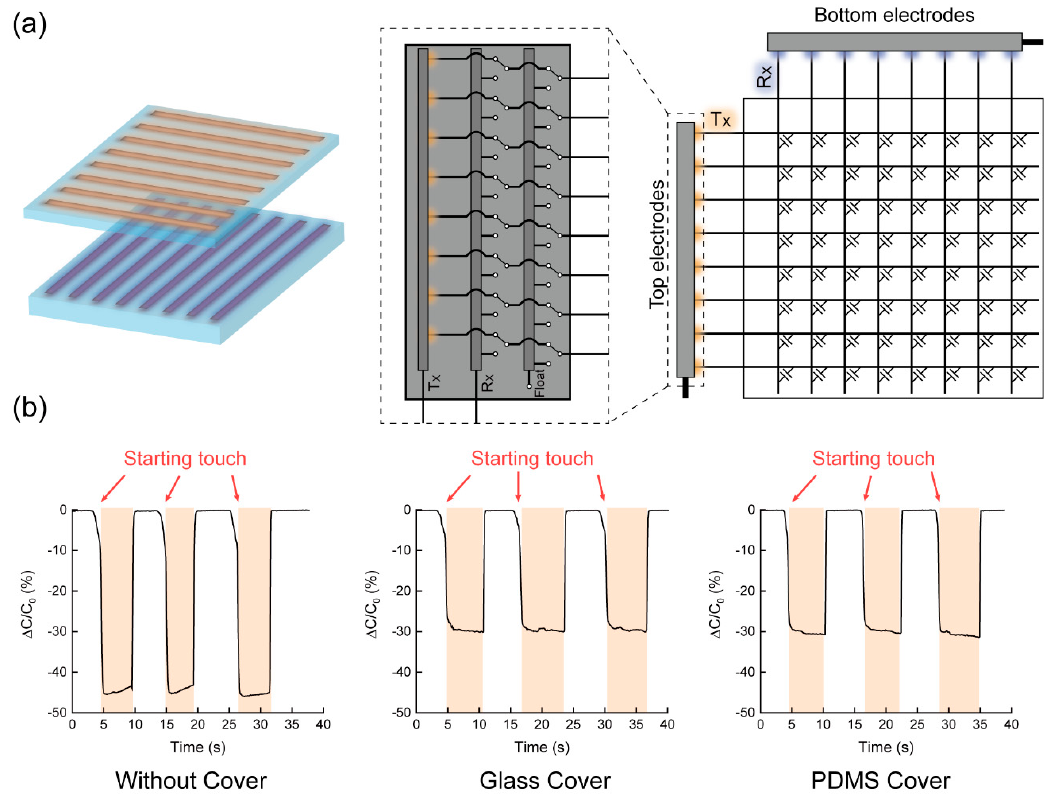
Figure 2. ( a ) Schematic view of electrode/circuit configuration of TSP for touch sensing mode and ( b ) and ( b ) capacitance change with finger touch for the three di ff erent cases of cover layer (no, glass, capacitance change with finger touch for the three different cases of cover layer (no, glass, polydimethylsiloxane polydimethylsiloxane (PDMS)).